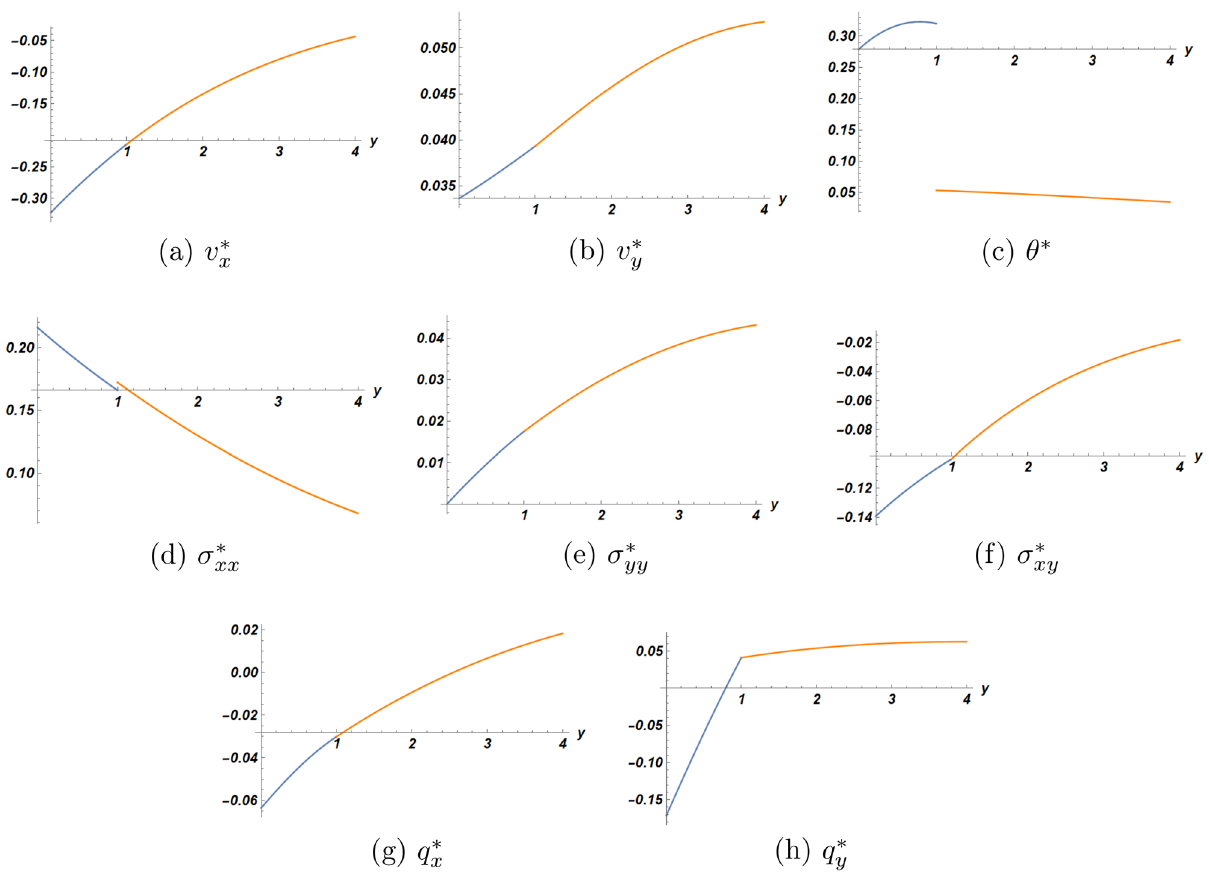
Figure 2. First order solution as function of y at x = 2.0 and t = 2.1 (blue dot) half-space (orange dot)